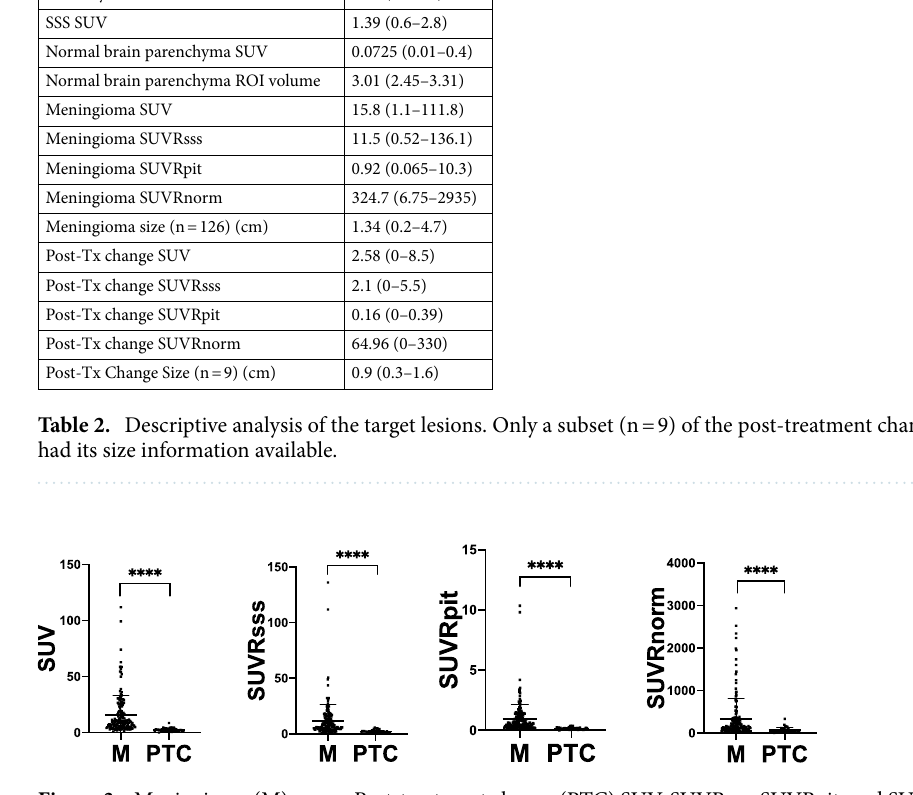
Figure 3. Meningioma (M) versus Post-treatment change (PTC) SUV, SUVRsss, SUVRpit, and SUVRnorm with mean and standard deviations. Mean SUV, SUVRsss, SUVRpit, and SUVRnorm of meningioma was 15.8, 11.5, 0.92, and 324.7 respectively. **** indicates statistical significance with p < 0.0001 as determined by Mann– Whitney test.